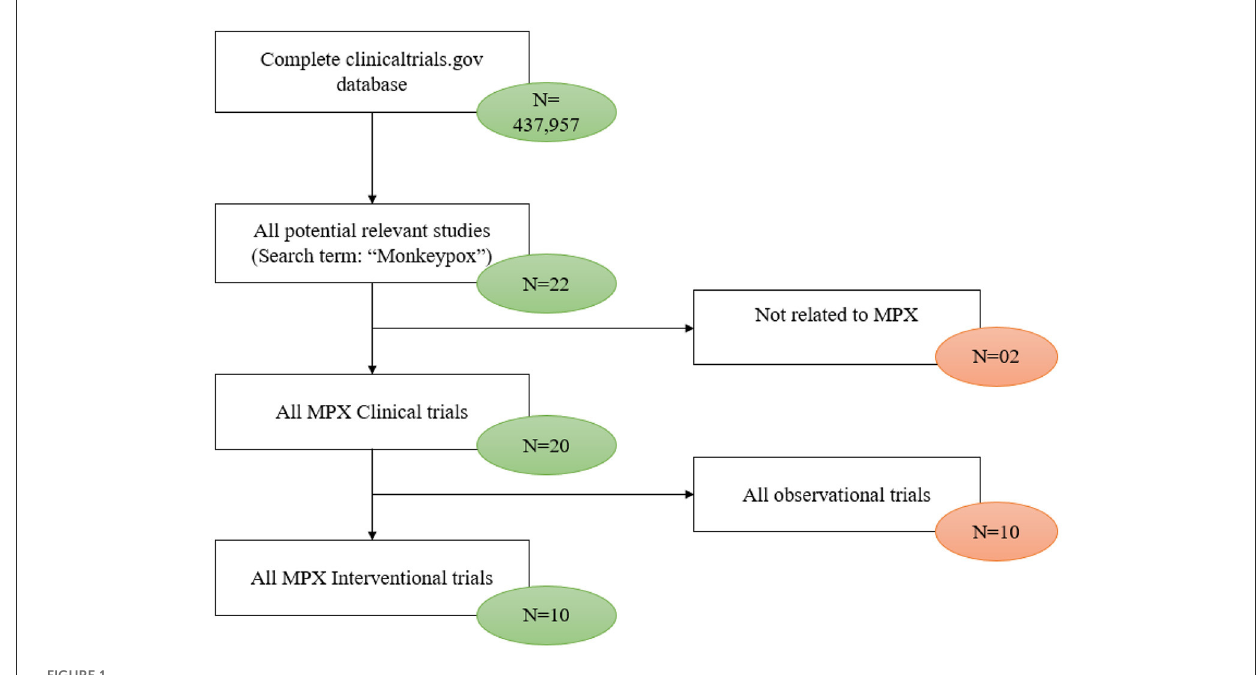
FIGURE1 Flow chart of clinical trial selection process.